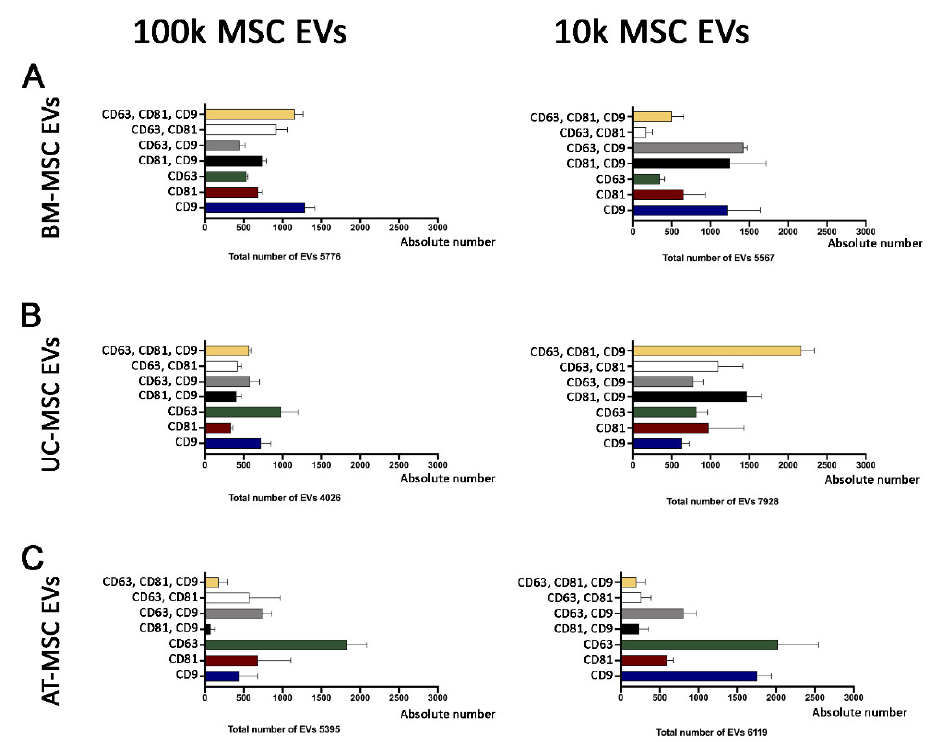
Figure 4. Super-resolution microscopy analysis of 100k and 10k MSC EVs. The graphs show triple positive, double positive and single positive EVs of 100k and 10k MSC EVs. ( A ) BM-MSC EVs, ( B ) UC-MSC EVs, ( C ) AT-MSC EVs. The total number of single EVs analysed is reported below each graph.